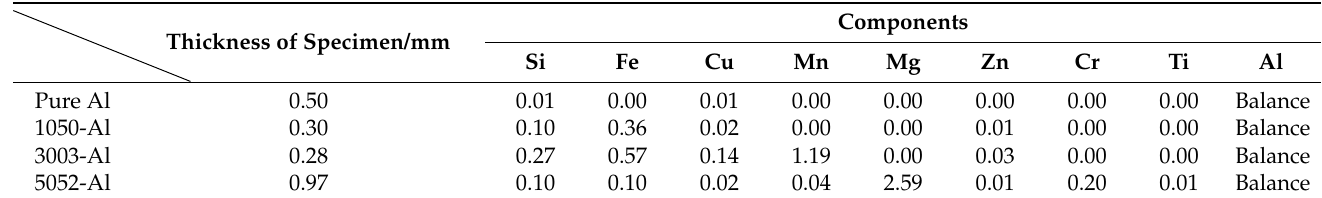
Table 1. Chemical composition and thickness of pure Al and Al alloys specimens.